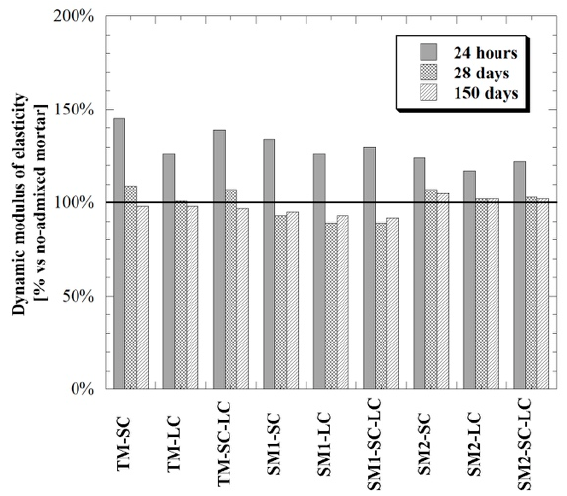
Figure 5. Elastic modulus of mortars with different admixtures normalized respect to mortars manufactured without admixtures.